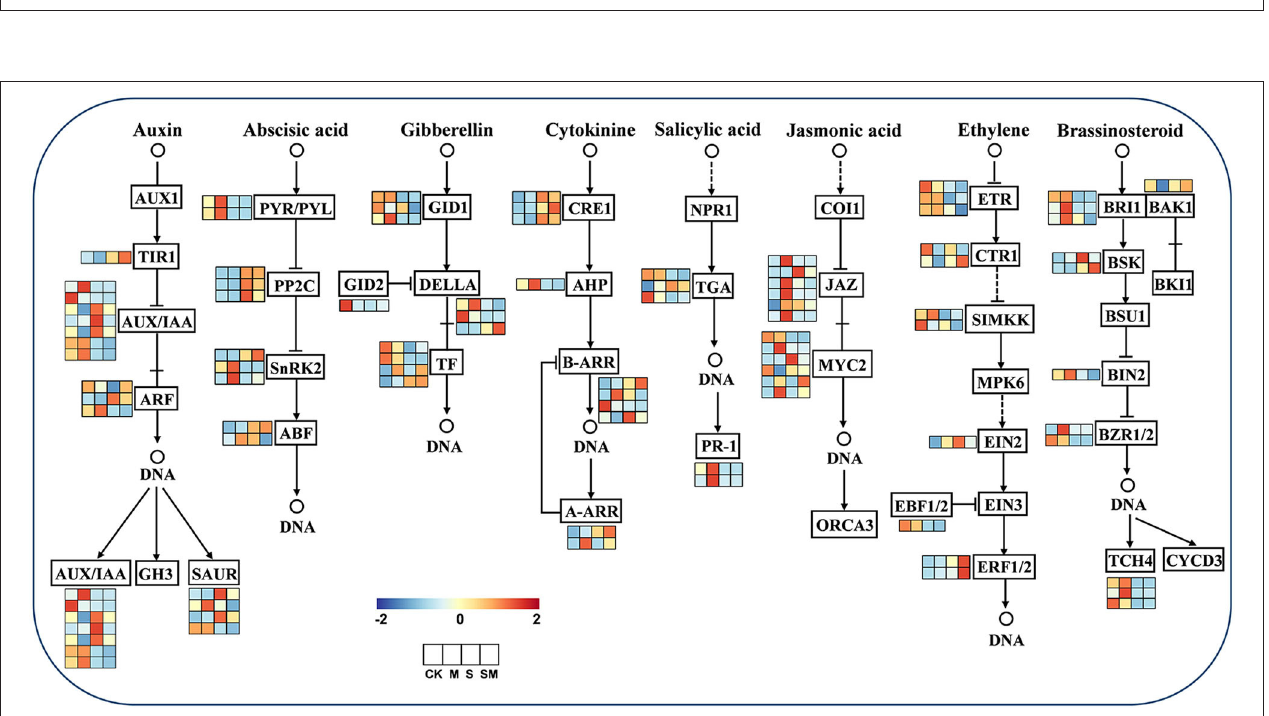
FIGURE 8 | Expression profiles of the plant hormone signal transduction pathway genes in response to MT and salt treatment.